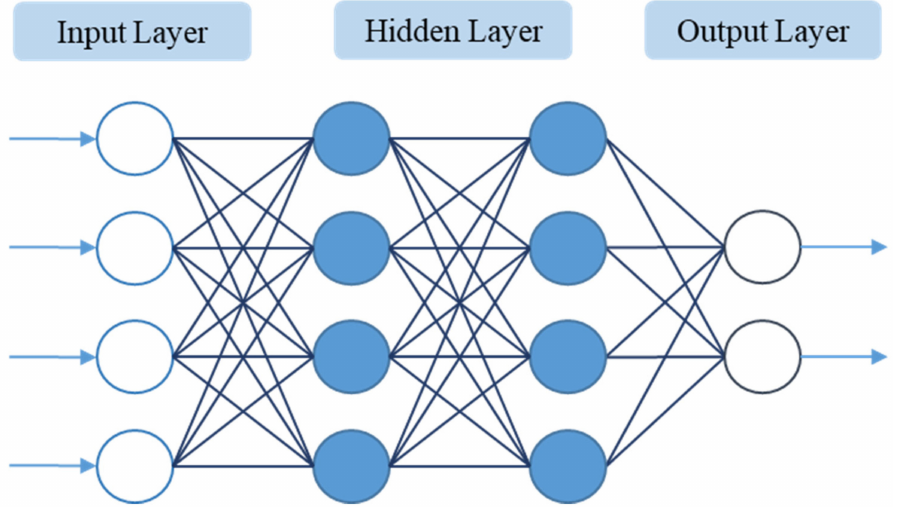
Figure 1. Artificial neural network